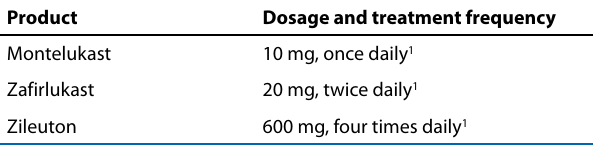
Table VIII : Treatment with antileukotrienes